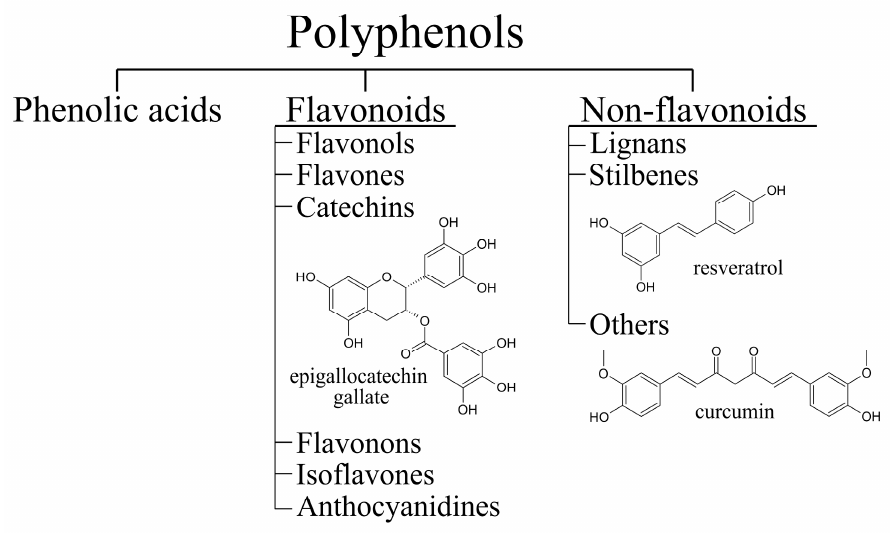
Figure 2. Classification of polyphenols with structural formulas of epigallocatechin gallate (EGCG), resveratrol and curcumin.